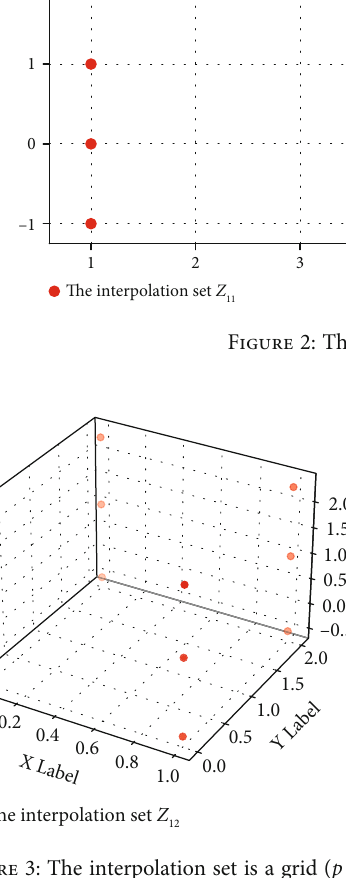
Figure 3: The interpolation set is a grid ( p = 3 ). Figure 4: The interpolation set is a random con fi guration ( p = 3